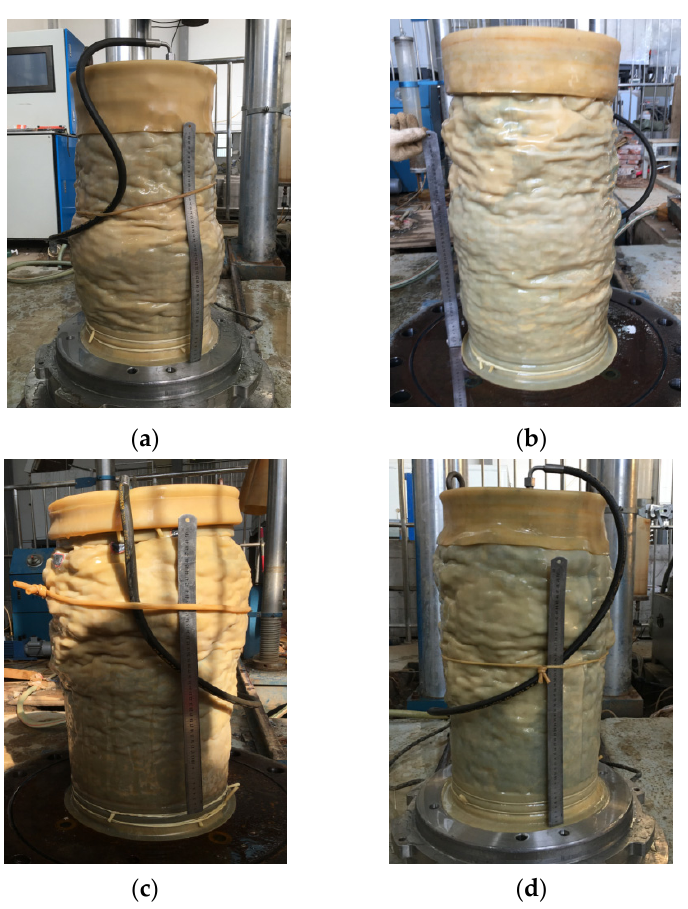
Figure 7. Shear damage characteristics of specimens at different reinforcement locations: ( a ) BGT/T1; ( b ) BGT/T2; ( c ) BGT/T3; ( d )